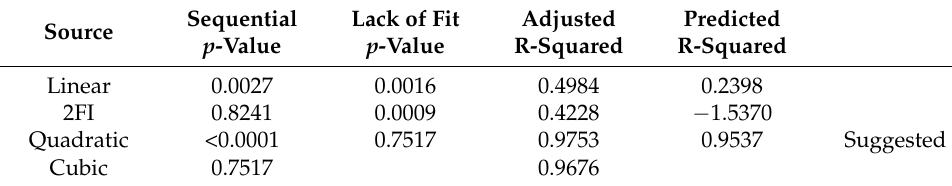
Table 1. Summary of model fitness.